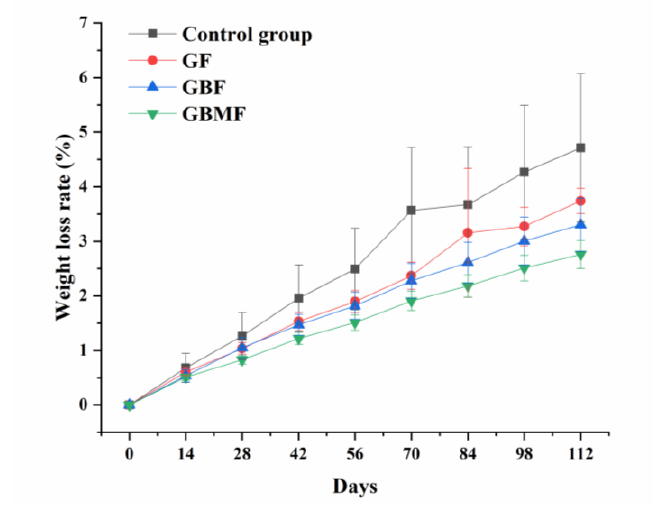
Figure 4. Changes in the weight loss rate of preserved eggs coated with different